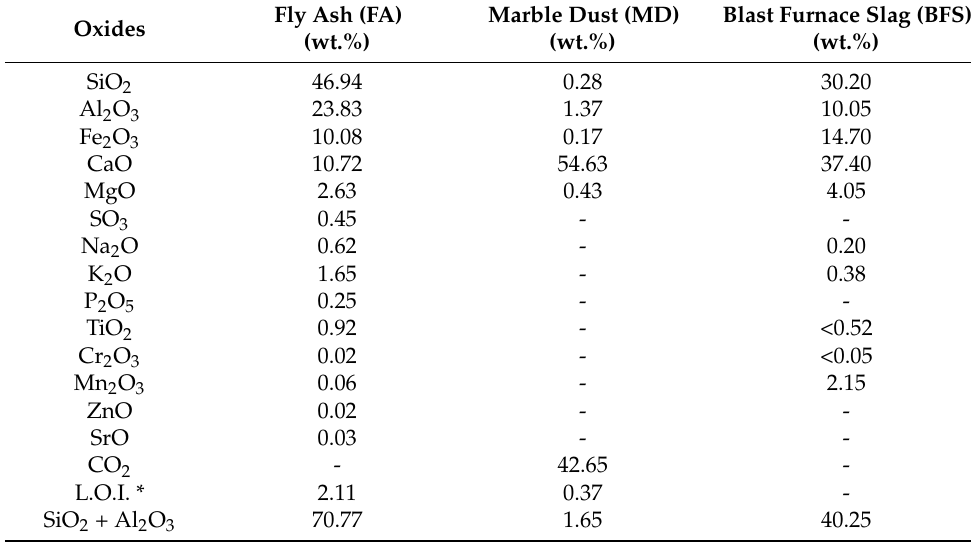
Table 2. Raw materials’ chemical